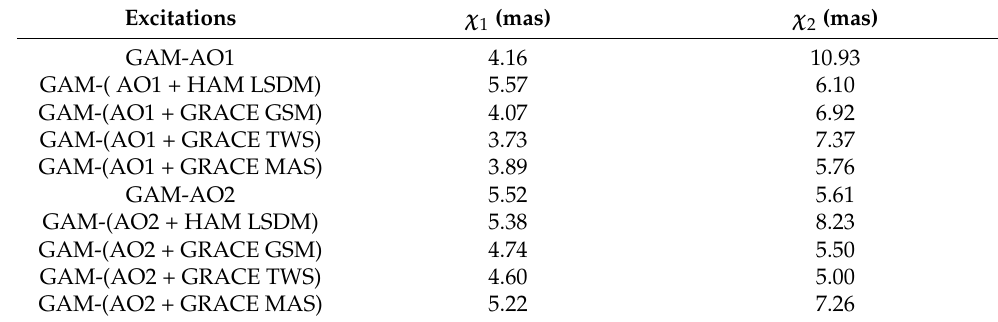
Table 3. RMS of the differences between geodetic and geophysical interannual PM excitations improved by different HAM